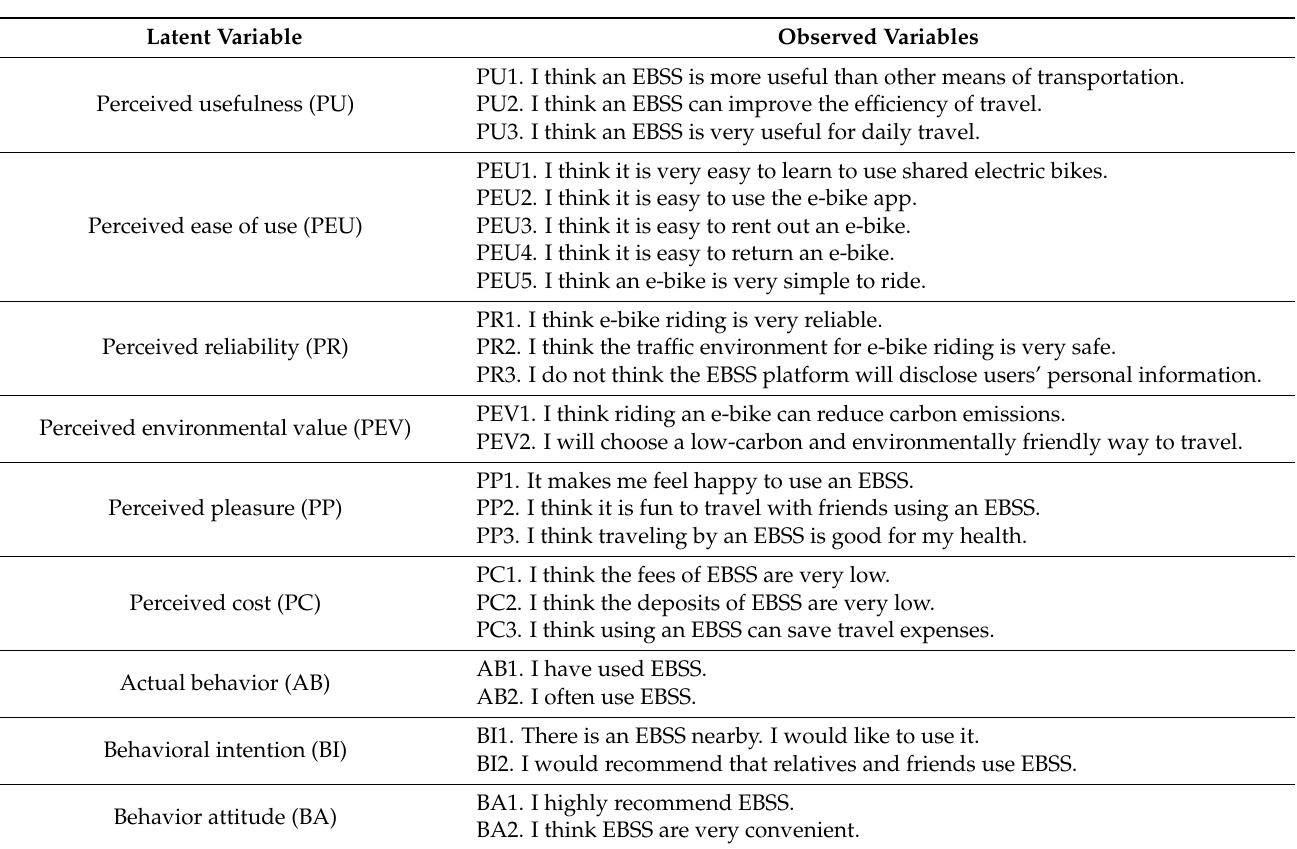
Table 2. Measurement scale